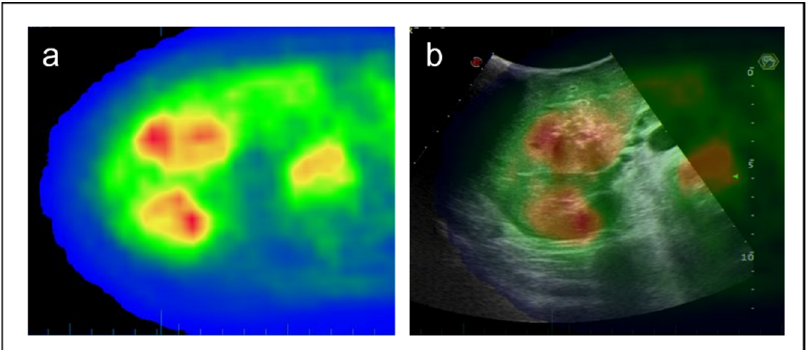
Figure 1. Navigation technology with the intraoperative fusion of preoperative PET-CT and IOUS. The tumour areas having different uptake at PET-CT are identified in vivo during surgery. ( a ) PET axial view of ICC; ( b ) Intraoperative fusion of PET-CT and IOUS images.